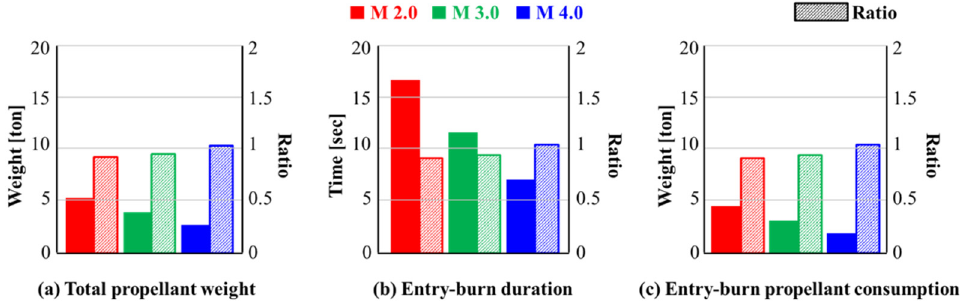
Figure 22. Summary of results with Entry-burn starting altitude of 60 and 80 km. ( a ) Total propellant weight; ( b ) Entry-burn duration; ( c ) Entry-burn propellant consumption. The air temperature decreases as the altitude changes from an altitude of 50 km. At